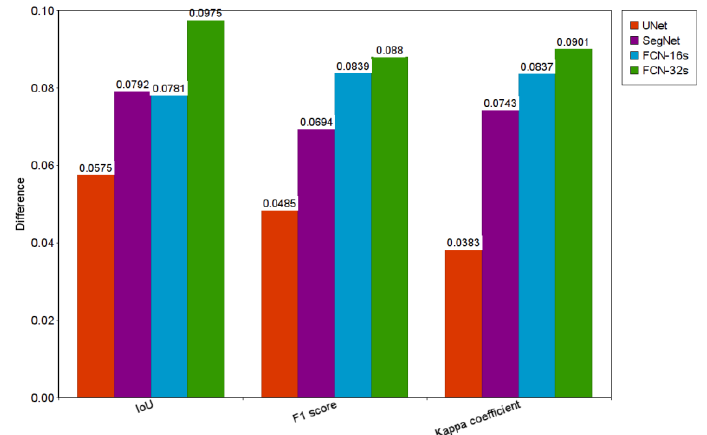
Figure 9. The di ff erence between two test sets in terms of IoU, F1 score, and Kappa coe ffi cient for Figure 9 . The difference between two test sets in terms of IoU, F1 score, and Kappa coefficient for each